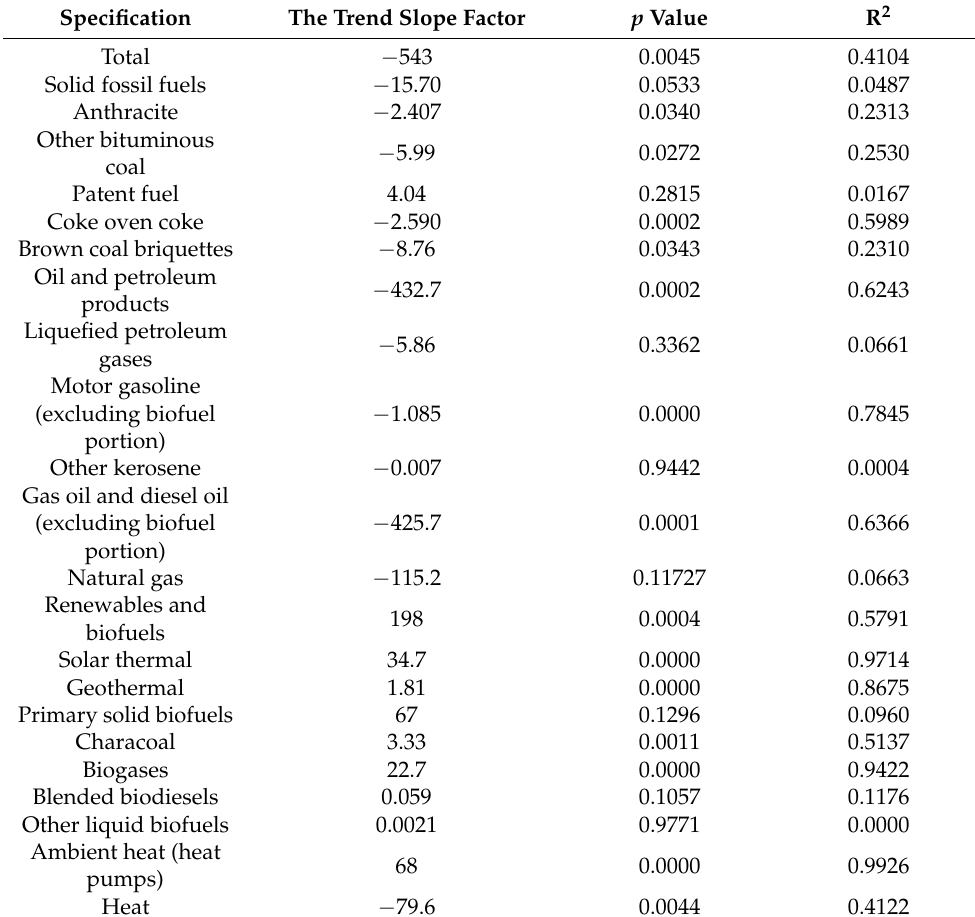
Table 6. Trends in the use of energy sources in German households in